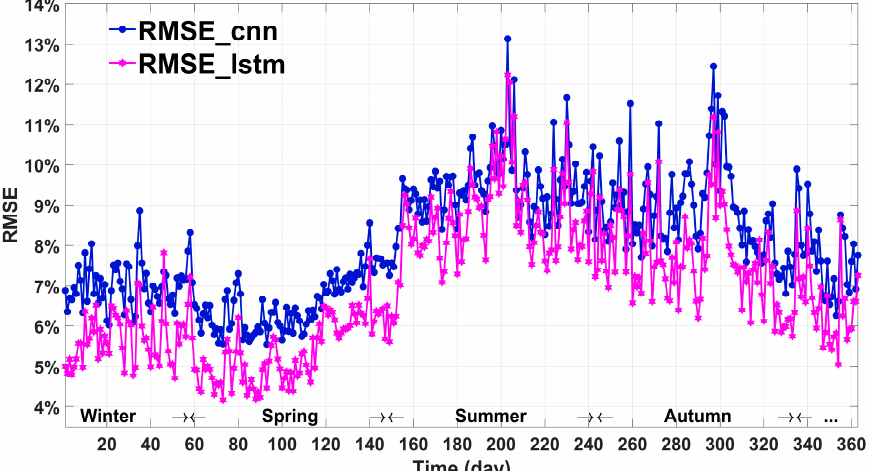
Figure 10. Comparison of the daily root-mean-squared-error (RMSE) between the CNNs and Con- vLSTM. The magenta line in the figure represents the RMSE of ConvLSTM, and the blue line represents the RMSE of CNNs. Table 4. Comparison of the RMSE between the CNNs and ConvLSTM. RMSE